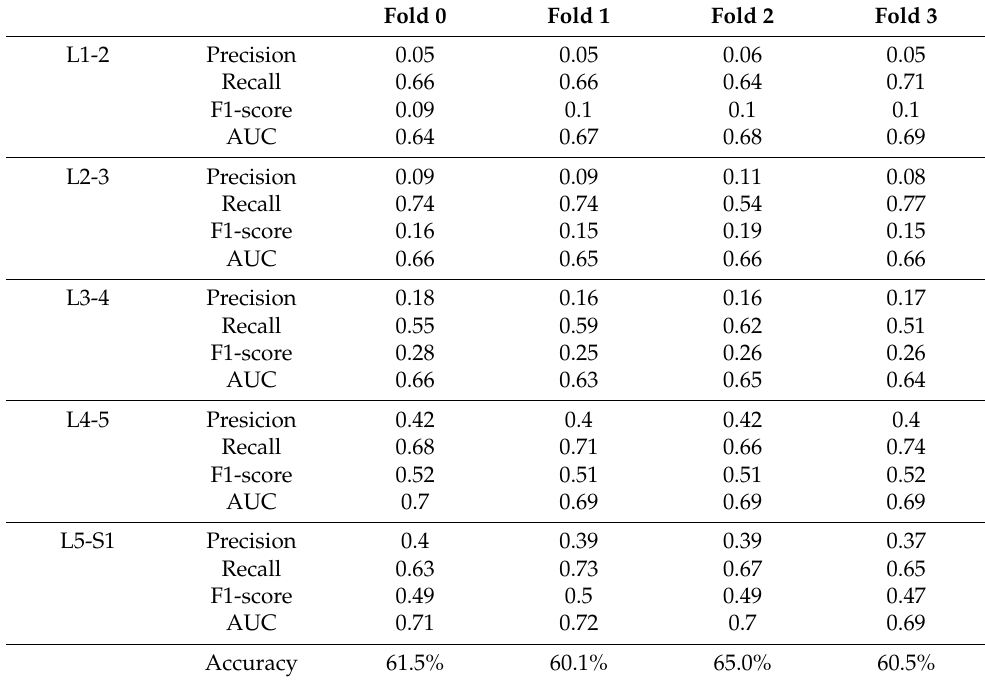
Table 4. Multitask results for predicting the presence of HNP in each level of lumbar through four-fold cross-validation.